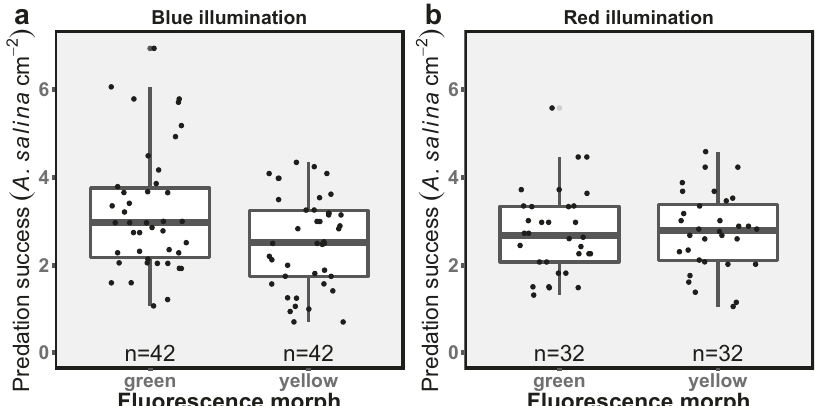
Fig. 6 The predation success of green and yellow fl uorescence morphs of Euphyllia paradivisa . a Predation success (number of captured Artemia salina normalized to cm 2 ) of green and yellow fl uorescence morphs of the coral E. paradivisa under blue illumination that excites fl uorescence; and b under fl uorescence non-exciting red illumination. The number of trials ( n ) for each morph is indicated below each box. Boxes represent the upper and lower quartile, centerlines represent medians, and whiskers extend to data measurements that are less than 1.5*IQR away from the fi rst/third quartile. Gray circle represents an